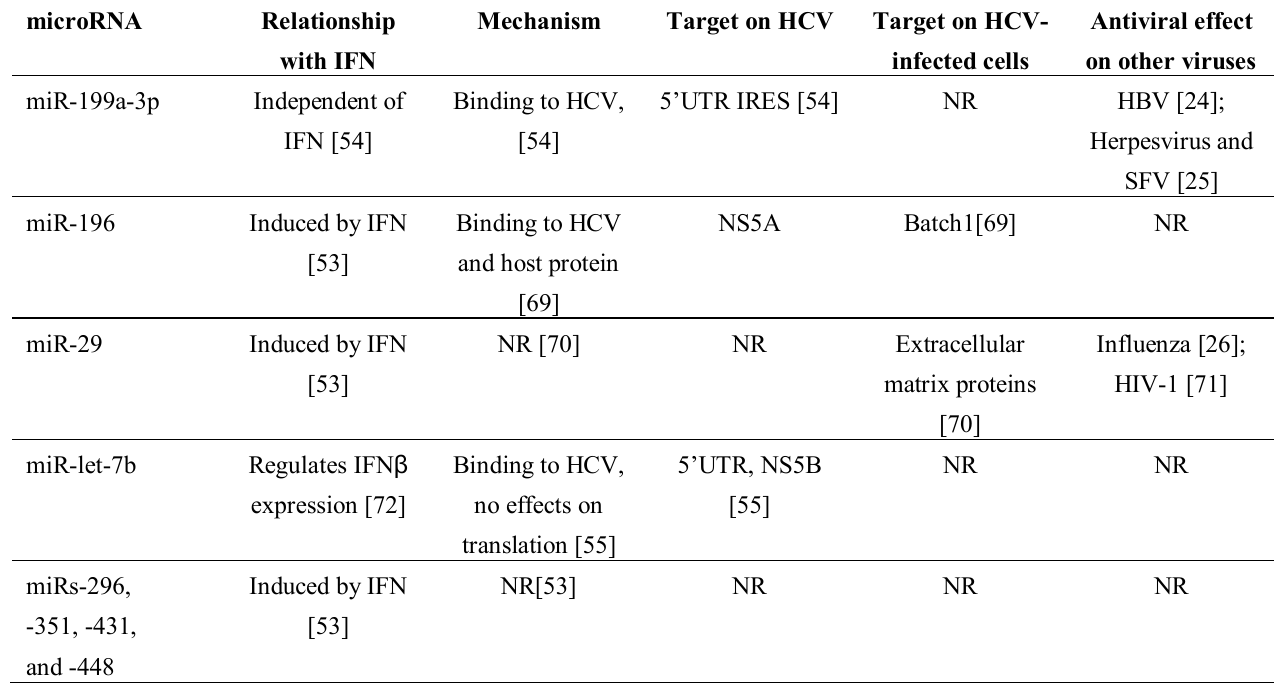
Table 2. MicroRNAs that inhibit HCV